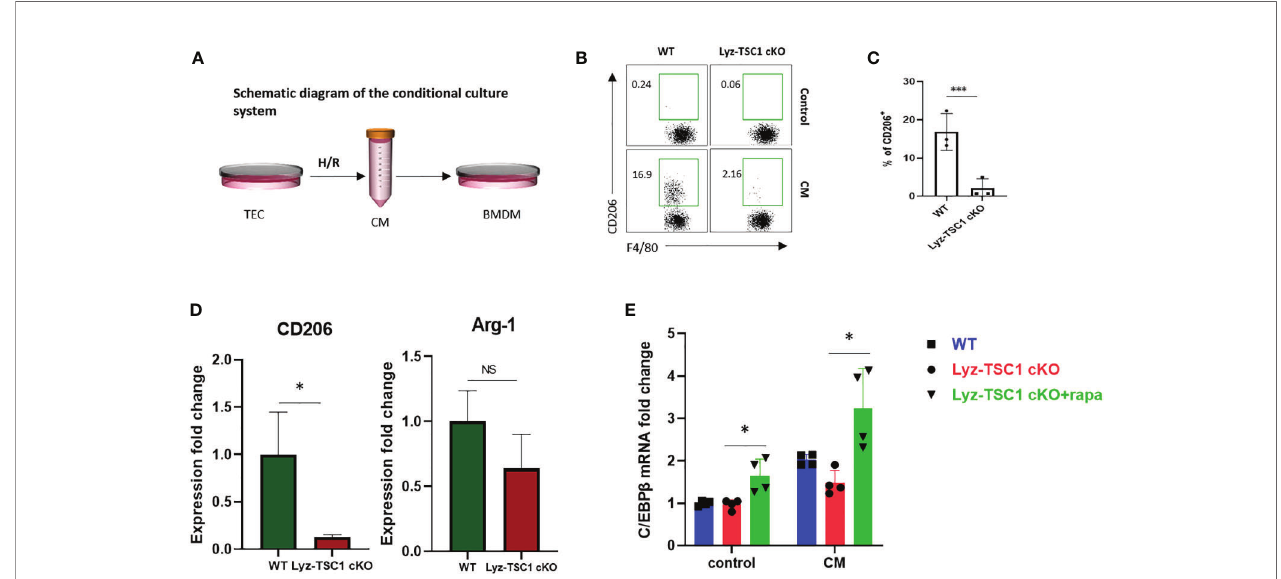
FIGURE 5 | Defective polarization to conditional medium of TSC1 cKO macrophages is mediated by mTOR-C/EBP b in vitro . (A) Experimental design of the BMDMs from the WT and Lyz-TSC1 cKO mice, which were treated with CM from mouse renal TECs (mRTECs) cell line after hypoxia-reoxygenation (H/R) injury. (B) Representative dot plots of the CD206 + subset in the F4/80 + compartment in the WT or TSC1 cKO BMDMs treated with conditional medium. (C) Quanti fi cation of the proportion of the CD206 + subset in F4/80 + macrophages. (D) Relative expression of CD206 and Arginase-1 (Arg-1) in WT or TSC1 cKO BMDMs treated with CM. (E) Lyz-tsc1 cKO BMDMs were pretreated with Rapa (100 nM) for 1 h and then stimulated with CM for an additional 48 h. C/EBP b expression in WT, Lyz-TSC1 cKO, and Lyz-TSC1 cKO treated with Rapa as determined by quantitative PCR after treatment with or without CM. In (C , D) , the data are shown as the mean ± SD and were analyzed by an unpaired two-tailed Student ’ s t-test (n ≥ 3). *P < 0.05; **P < 0.01; NS, not signi fi